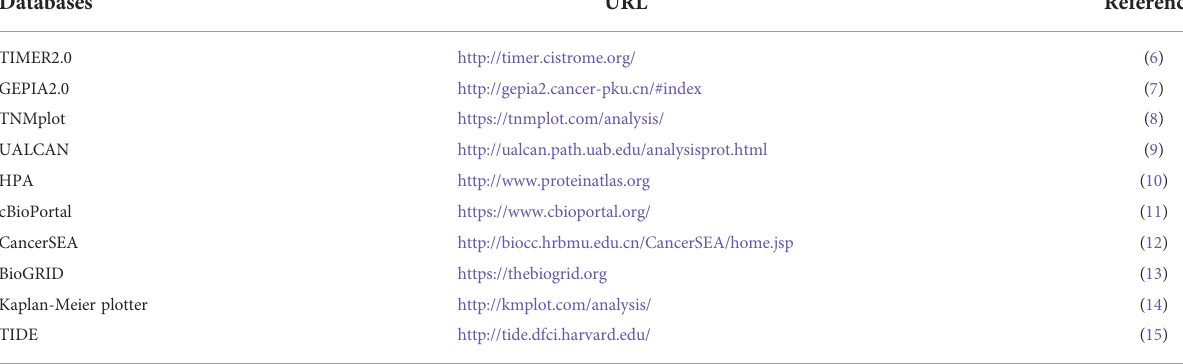
TABLE 1 The bioinformatics databases that are applied for exploring regulation functions of LIAS.